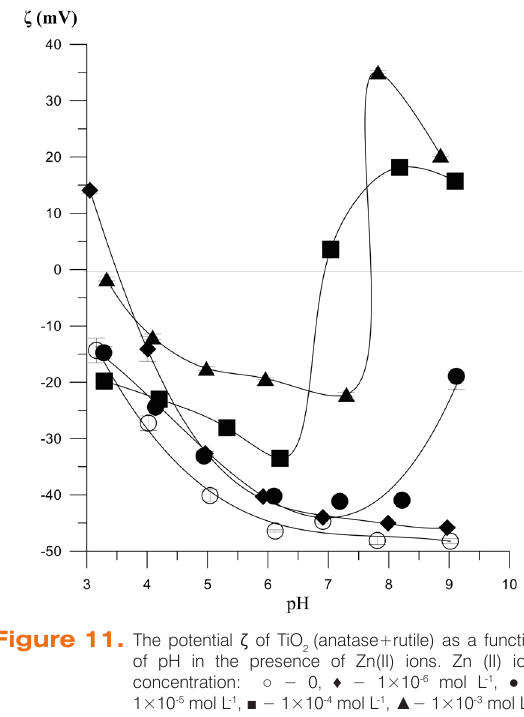
Figure 11. The potential ζ of TiO (anatase+rutile) as a function 2 of pH in the presence of Zn(II) ions. Zn (II) ions